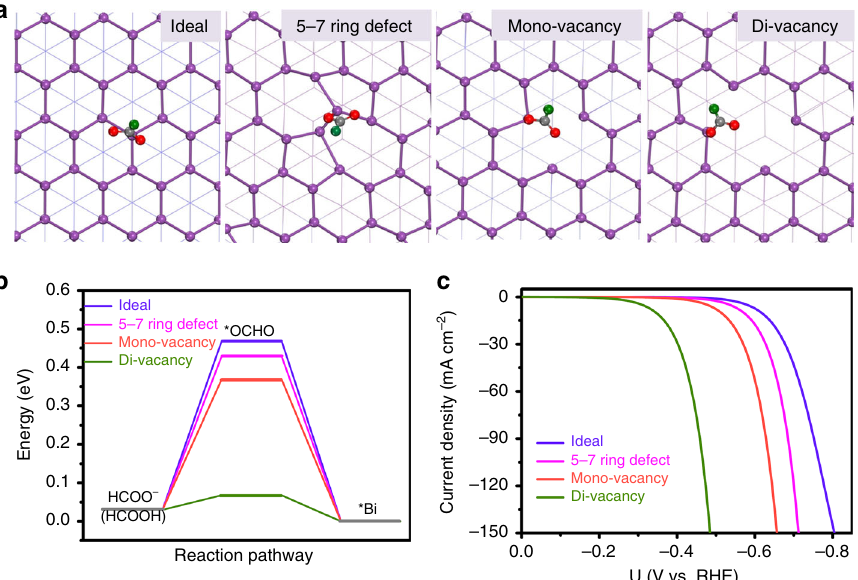
Fig. 4 Theoretical calculations of reaction pathway on ideal and defective Bi(001) surfaces. a Optimized geometric structures of *OCHO adsorbed on ideal and three defective Bi(001) surfaces as indicated; the pink, gray, red, and green spheres represent Bi, C, O, and H atoms, respectively. b Free-energy pro fi les for formate production on ideal and defective surfaces. c Corresponding simulated CO 2 RR polarization